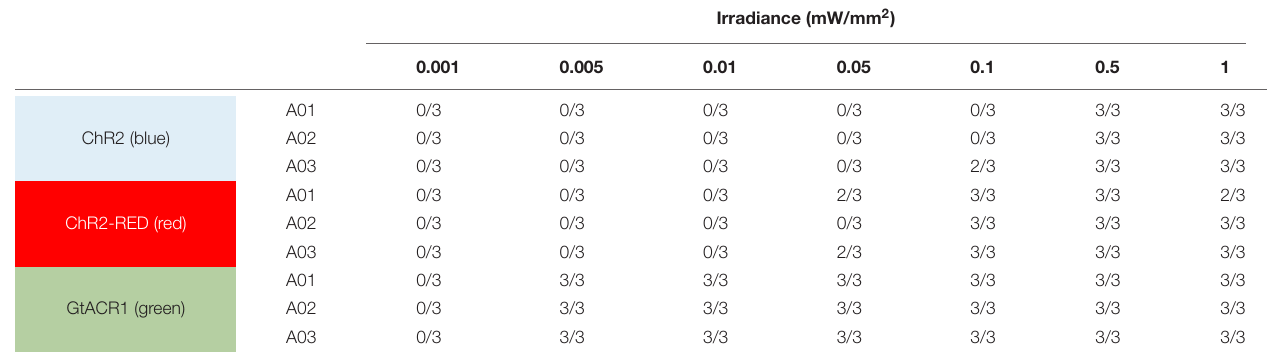
TABLE 1 | Defibrillation success rates for ChR2, ChR2-RED, or GtACR1-expressing atrial models for different irradiance